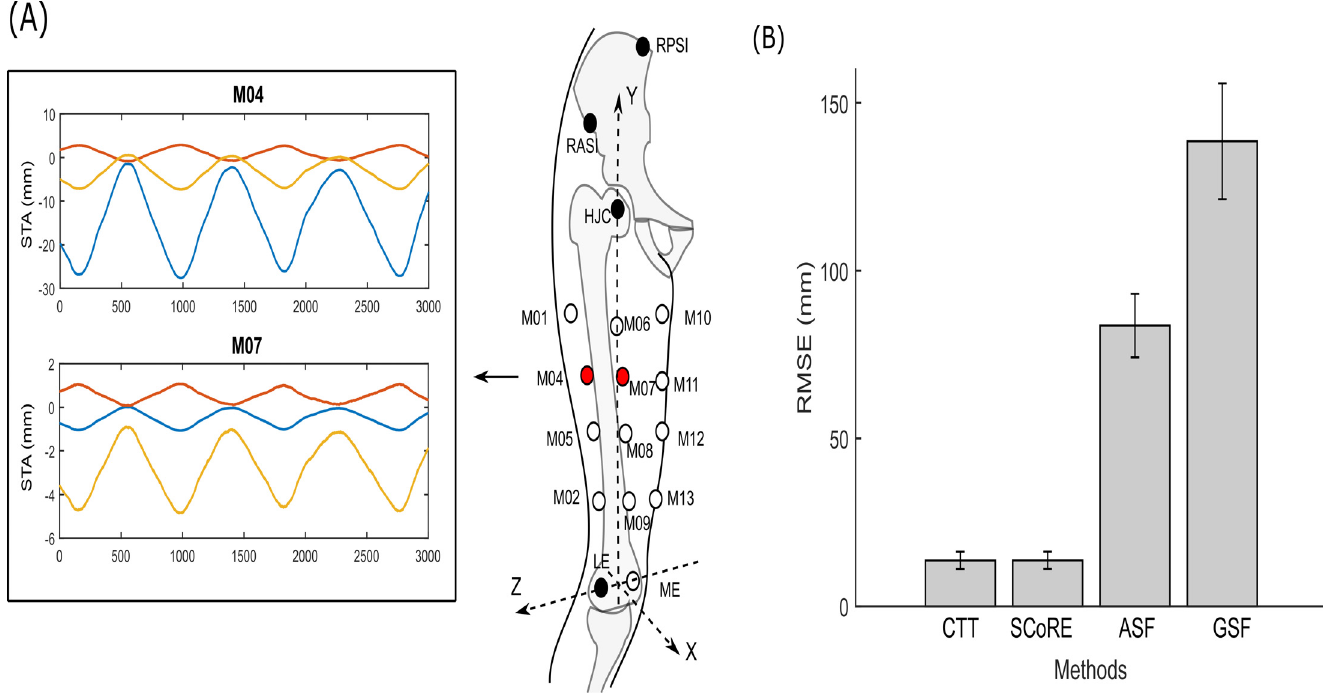
Fig 7. The CoR estimate results when noise modelled from realistic soft tissue artefacts (STA) was introduced. (A) The realistic STA was modelled based on a linear relationship of hip joint angle in femoral anatomical coordinate system (ACS) of the mechanical linkage for “fast and normal” motion. The ex-vivo data from [23] was used. The dataset provides the pelvic and femoral ACS and STA characteristics of 12 markers in the femoral ACS during hip movement. M04 and M07 markers were selected to model the STA because their marker positions are mostly close to the cluster placements on the segment. A mathematical model was used based on a linear relationship between the measured STA and hip joint kinematics and model coefficients of M04 and M07 markers were calculated using least square methods respectively. (B) Errors of CoR localisation with all four algorithms when the modelled STA applied to the distal markers.